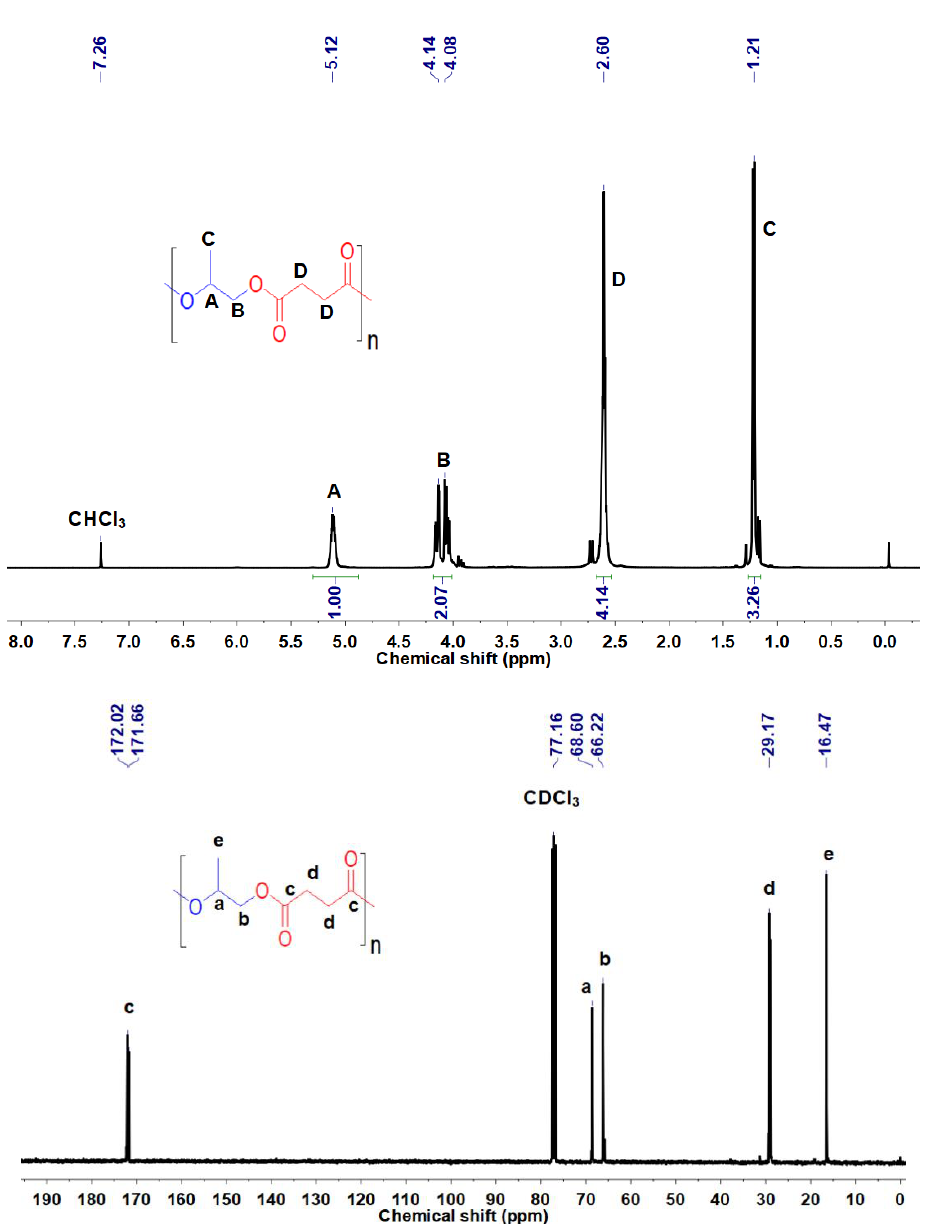
Figure 3. NMR spectra of purified poly(propylene succinate) in CDCl 3 . Top: 1 H NMR spectrum. Bottom: 13 C NMR spectrum (entry 1, Table 2).